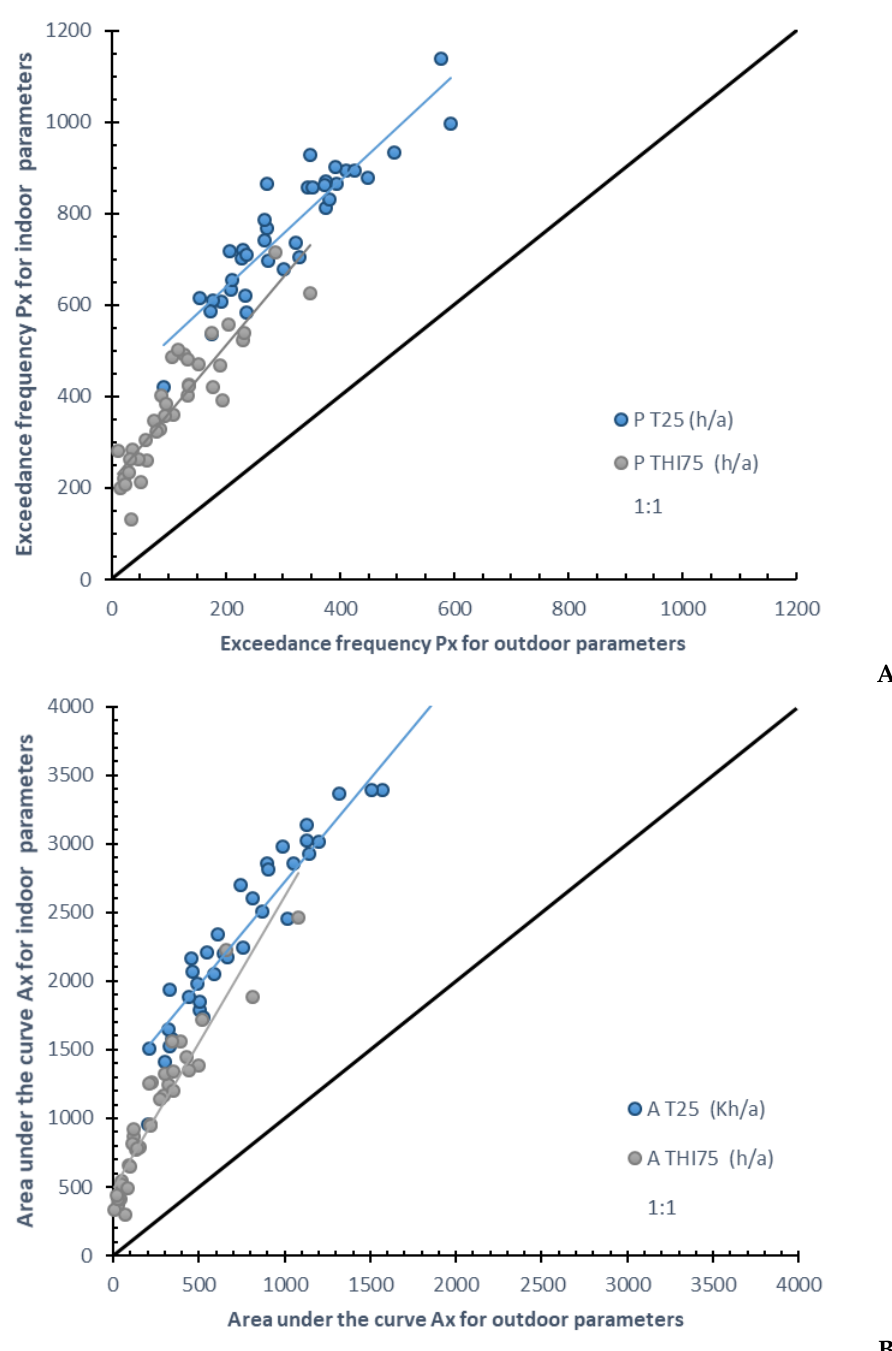
Figure 2. Relationship between the weather-related vector of heat stress indices I EXT = [P T25 , A T25 , P THI75 , A THI75 ] and the indoor-related vector of HS indices I INT = [P T25 , A T25 , P THI75 , A THI75 ]. The exceedance frequencies of a threshold P T25 and P THI75 (h/a) are presented in panel ( A ), the heat stress intensities (area under the curve for a threshold) A T25 (Kh/a) and A THI75 (h/a) in panel ( B ). The parameters of the linear regression are summarized in Table 2.